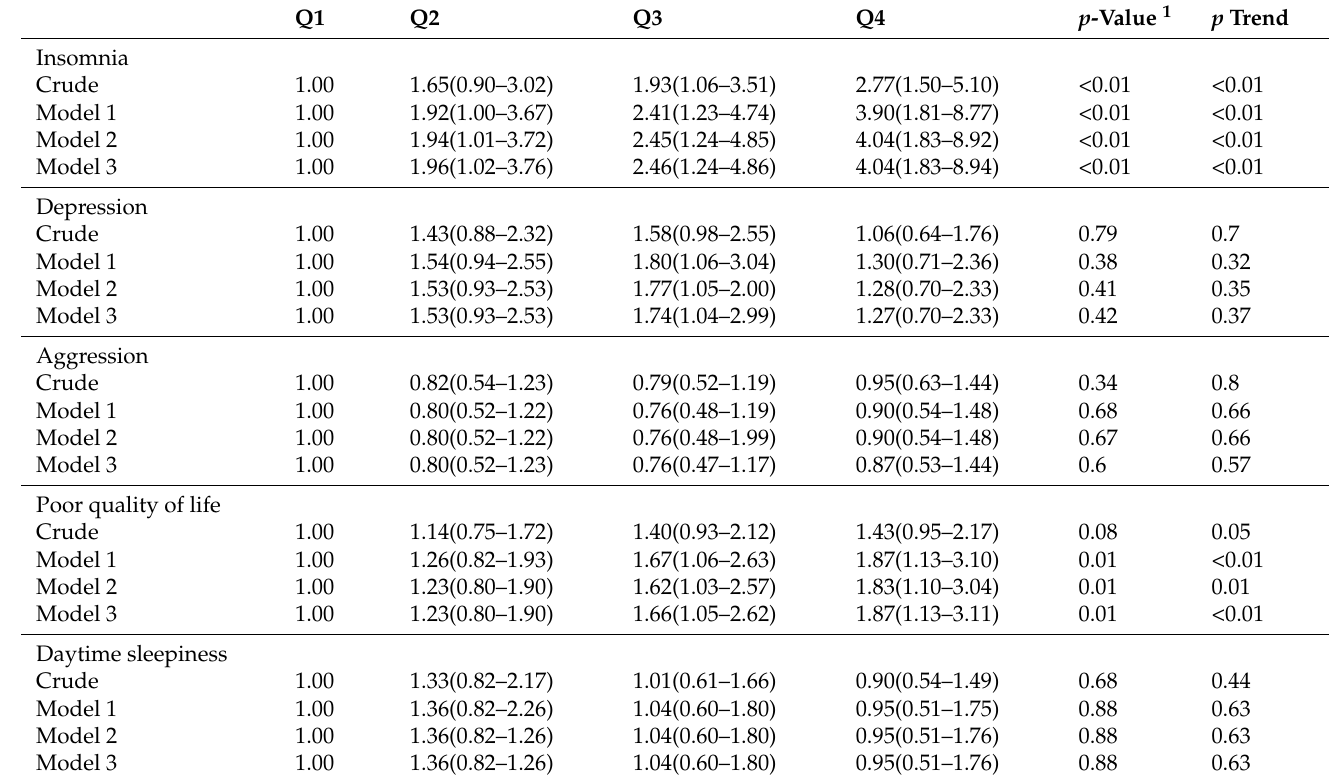
Table 3. Multivariable-adjusted odds ratio of the associations between ultra-process food intake and insomnia, depression, aggression, poor quality of life, daytime